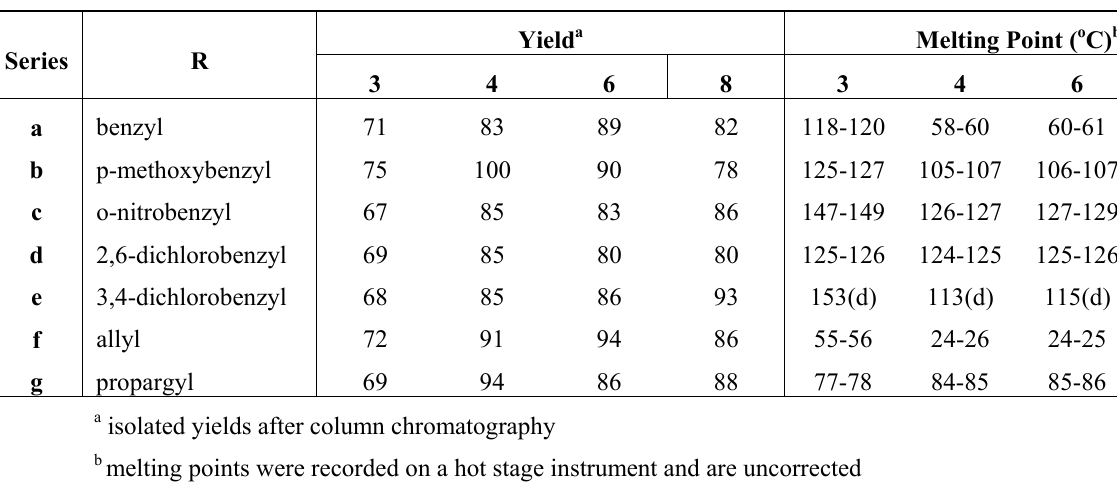
Table 1. Yields and Melting